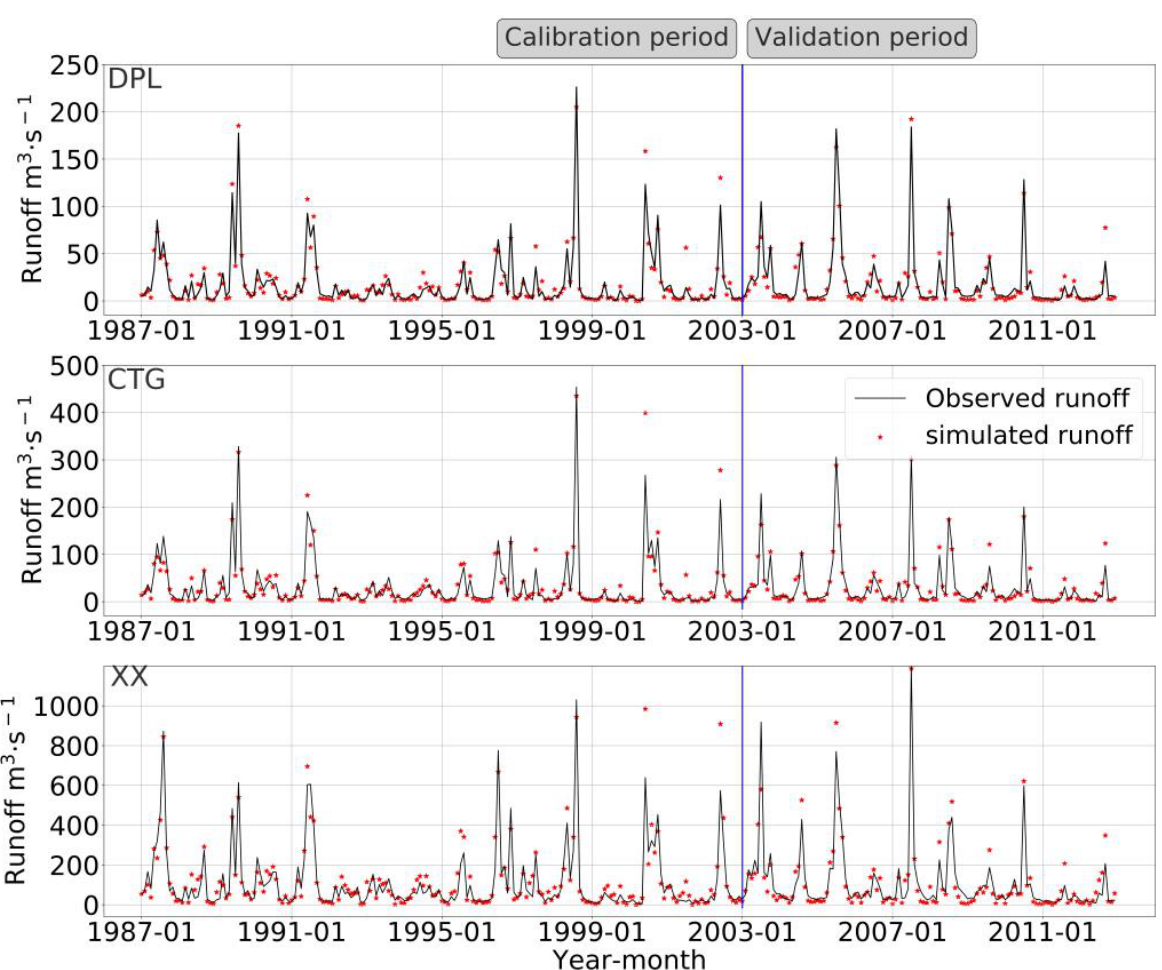
Table 2. Evaluation indicators for SWAT model calibration.